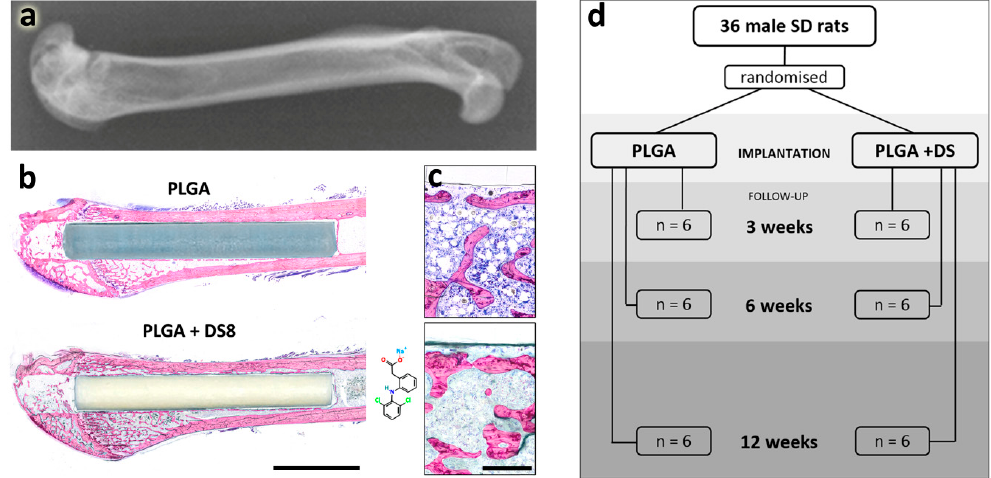
Figure 1. Experimental setup. ( a ) Experiments were conducted in the femur of rats: X-ray illustrating the anatomical region. ( b ) Poly(lactide-co-glycolide) (PLGA) and PLGA + DS8 rods were implanted in the femoral shaft via a drill hole created in the intercondylar space of the femur. Scale bar, 5 mm. ( c ) Magnified images of new bone formation in ( b ), scale bar, 300 µ m. ( d ) illustrates the experimental setup: number of rats assigned to PLGA and PLGA + DS8 groups and respective follow-up